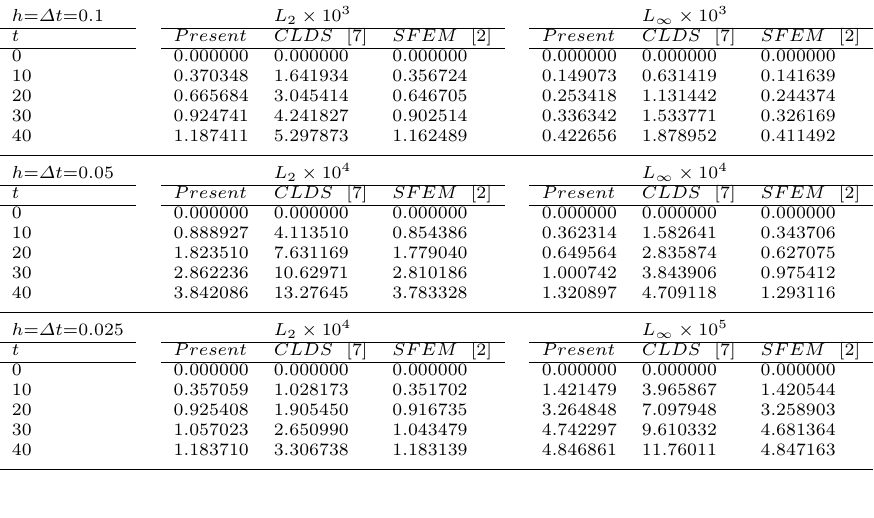
Table 3. Comparison of error norms for single solitary wave with a = b = c = 1, d = 0 . 5, v = 1 . 18, different values of h and ∆t .